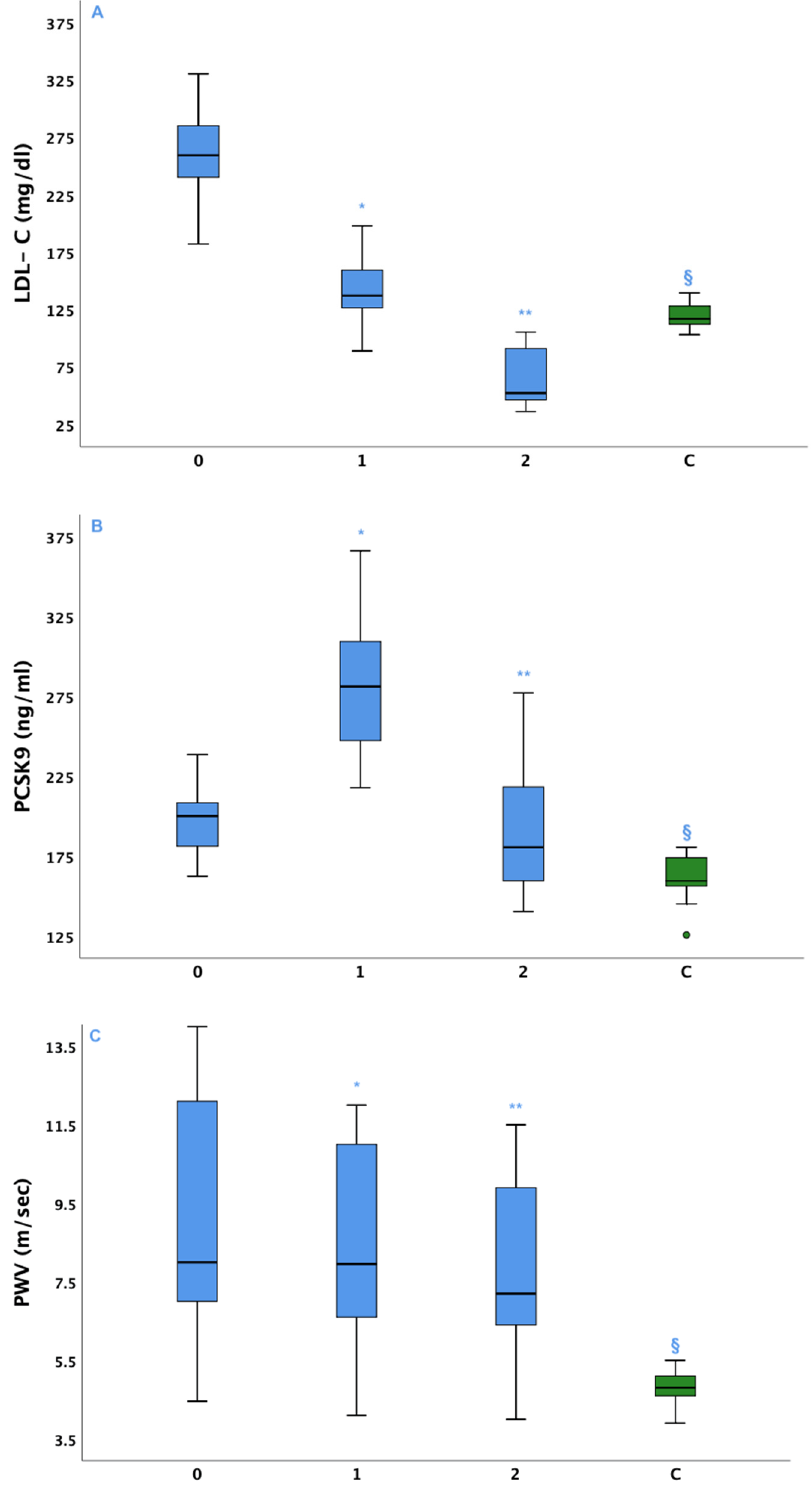
Figure 1. Box and whiskers plots describing LDL-C values, PCSK9 and PWV over time in HeFH and controls. Solid horizontal lines = median values; error bars = 95% Confidence intervals; Shaded area = Interquartile range. Panel ( A ): LDL-C: * p < 0.001 vs. baseline; ** p < 0.001 vs. both baseline and T1; § p < 0.001 vs. HeFH each timepoint. Panel ( B ): PCSK9: * p < 0.001 vs. baseline; ** p < 0.001 vs. both baseline and T1; § p < 0.001 vs. HeFH each timepoint. Panel ( C ): PWV: * p < 0.001 vs. baseline; ** p < 0.001 vs. both baseline and T1; § p < 0.001 vs. HeFH each timepoint.